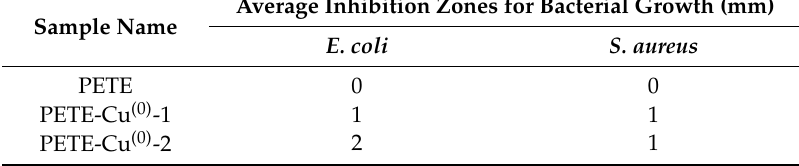
Table 8. Results of tests on the antibacterial activity of PETE-Cu (0) composites, procedure in accordance with the EN ISO 20645:2006. [119].